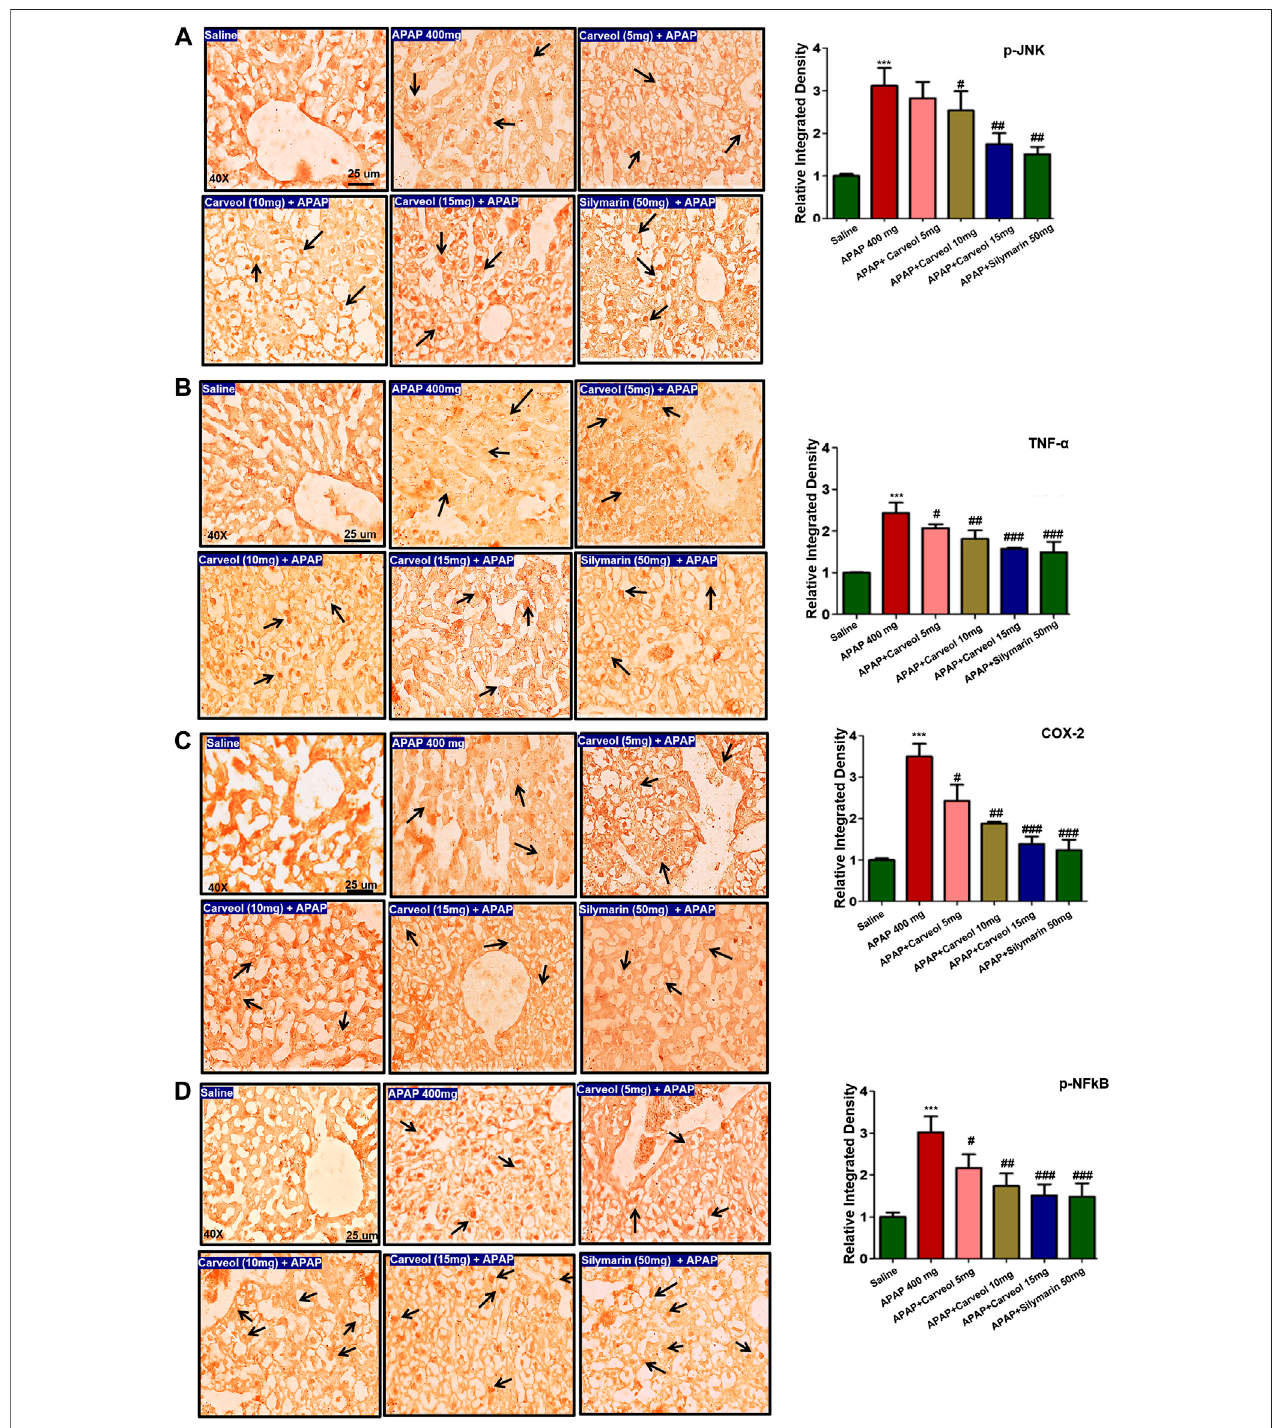
Figure5| Effectofcarveolonin fl ammatorymediators.Thepresentedimagesindicateimmunoreactivityof (A) p-JNK (B) TNF- α (C) COX-2,and (D) p-NF κ B.Scale bar (cid:1) 25 μ m, magni fi cation × 40 with n (cid:1) 7/group. The data presented are relative to saline and the number of experiments performed (cid:1) 3. The data are presented as means ± SEMandwereanalyzedusingone-wayANOVAfollowedbyTukey ’ smultiplecomparisontest. Thesymbols ppp and###representsigni fi cantdifferencevalues of p < 0.001, while the symbol ## represent p < 0.01 values for signi fi cant differences and # represents p < 0.05. The slides were processed from cohort 1.